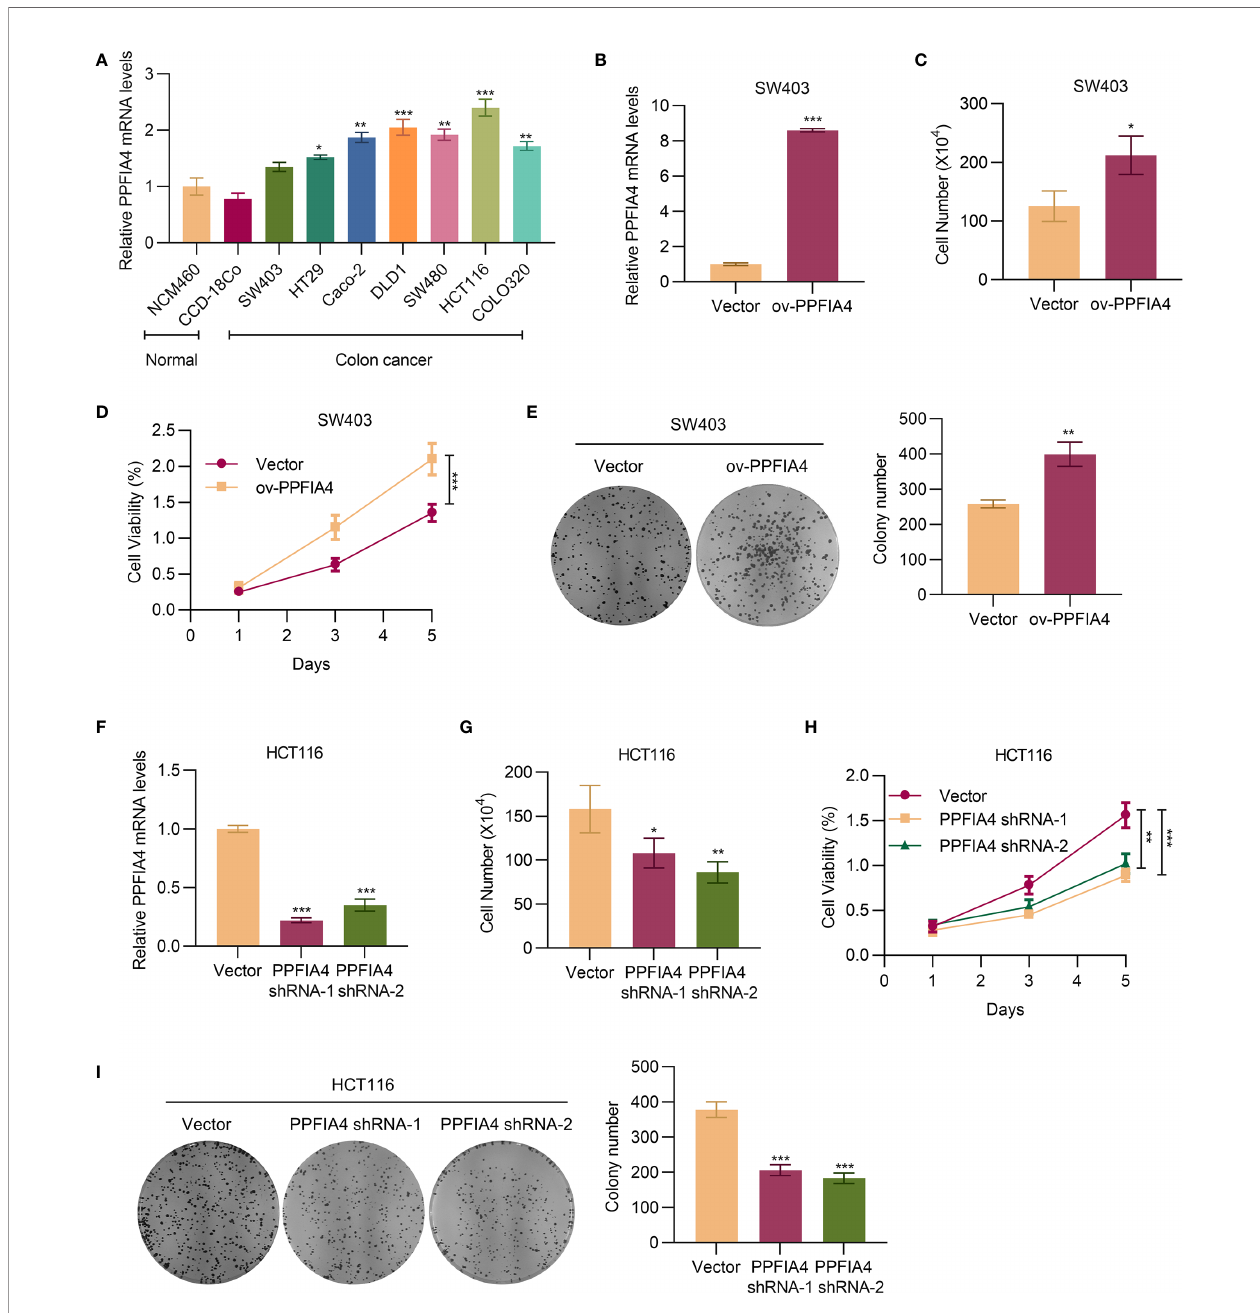
FIGURE 2 | PPFIA4 promotes colon cancer cell proliferation. (A) The mRNA expression of PPFIA4 in colon cancer cell lines or normal colon cell lines. (B) qPCR analysis of the mRNA level of PPFIA4 in SW403 cells transfected with PPFIA4 expression plasmid. Viability of SW403 cells transfected with PPFIA4 expression plasmid determined using cell counting assay (C) , CCK8 assay (D) , and foci formation assay (E) . (F) The mRNA level of PPFIA4 in HCT116 cells transfected with PPFIA4 shRNA. Viability of HCT116 cells transfected with PPFIA4 shRNA determined by cell counting (G) , CCK8 assay (H) and foci formation assay (I) . *p < 0.05, **p < 0.01, ***p <